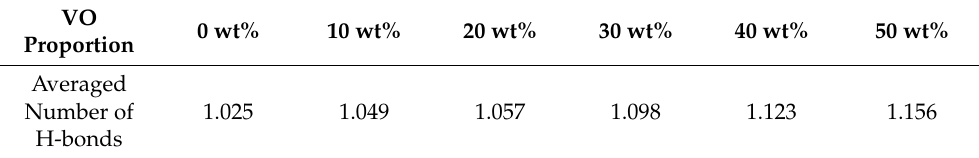
Table 9. The average number of H-bonds per water molecule in mixed oil models with 2wt% of water content.